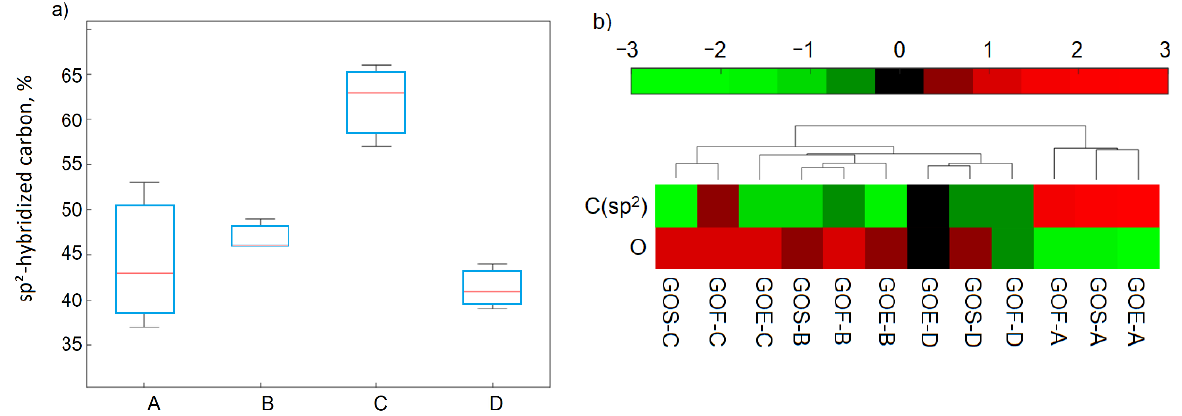
Figure 4. Box plot of C1sp 2 hybridization as a function of the applied method ( a ) and clustered heat map of selected variables (for the studied GO) ( b ).